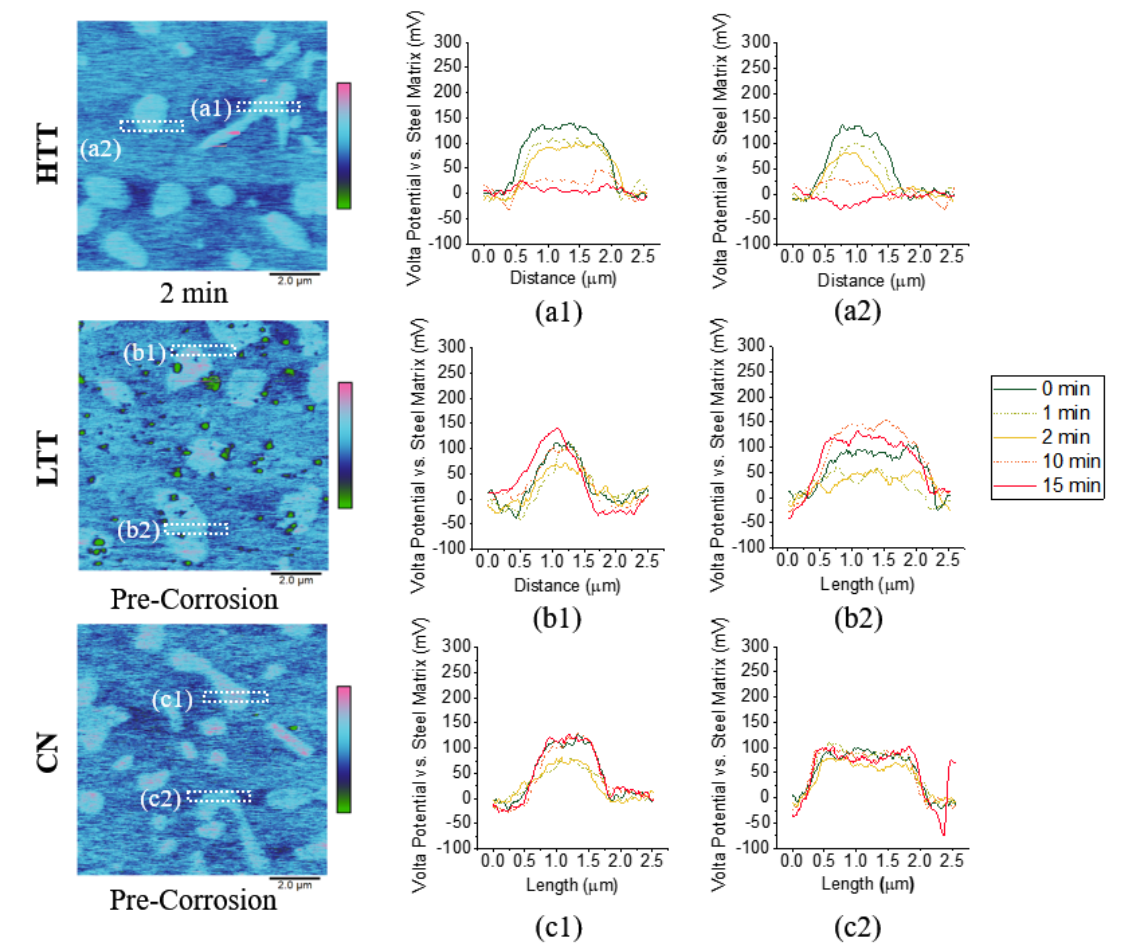
Figure 7. SKPFM Volta potential maps (( a , b , c ) 600 mV full scale, exposure time given below each image) for each of the three heat-treated MSSs with time-dependent Volta potential profiles ( a1 – c2 ) across two representative carbides plotted as a function of duration of exposure to 1 M NaCl solution. The location of the carbide represented by each profile is indicated by the corresponding dotted box in the exemplary SKPFM maps at